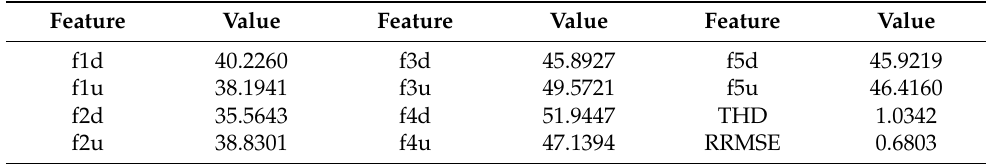
Table 8. Extracted features for lathe classification.